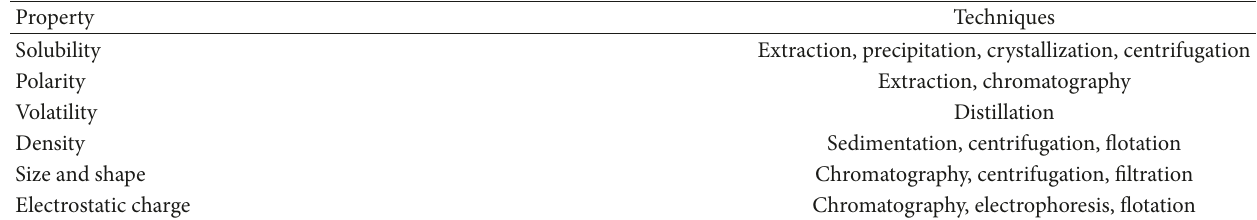
Table 3: Selected techniques used in the pretreatment based on properties of